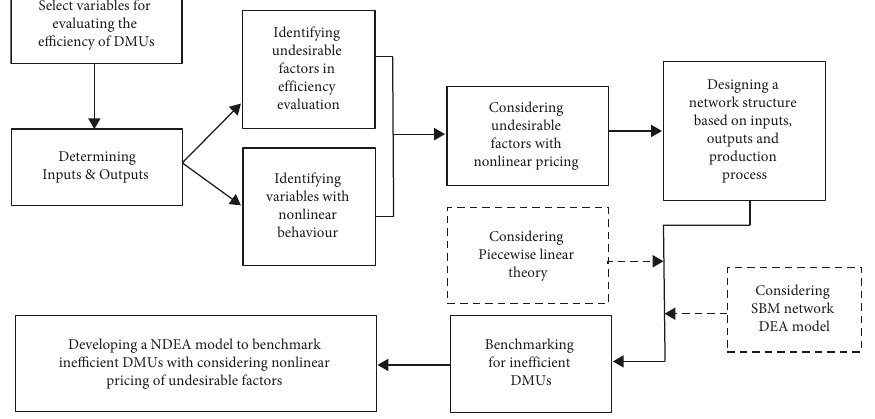
Figure 2: Steps of